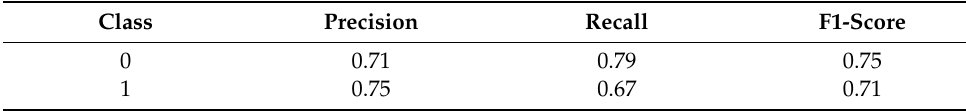
Table 5. Precision, recall and